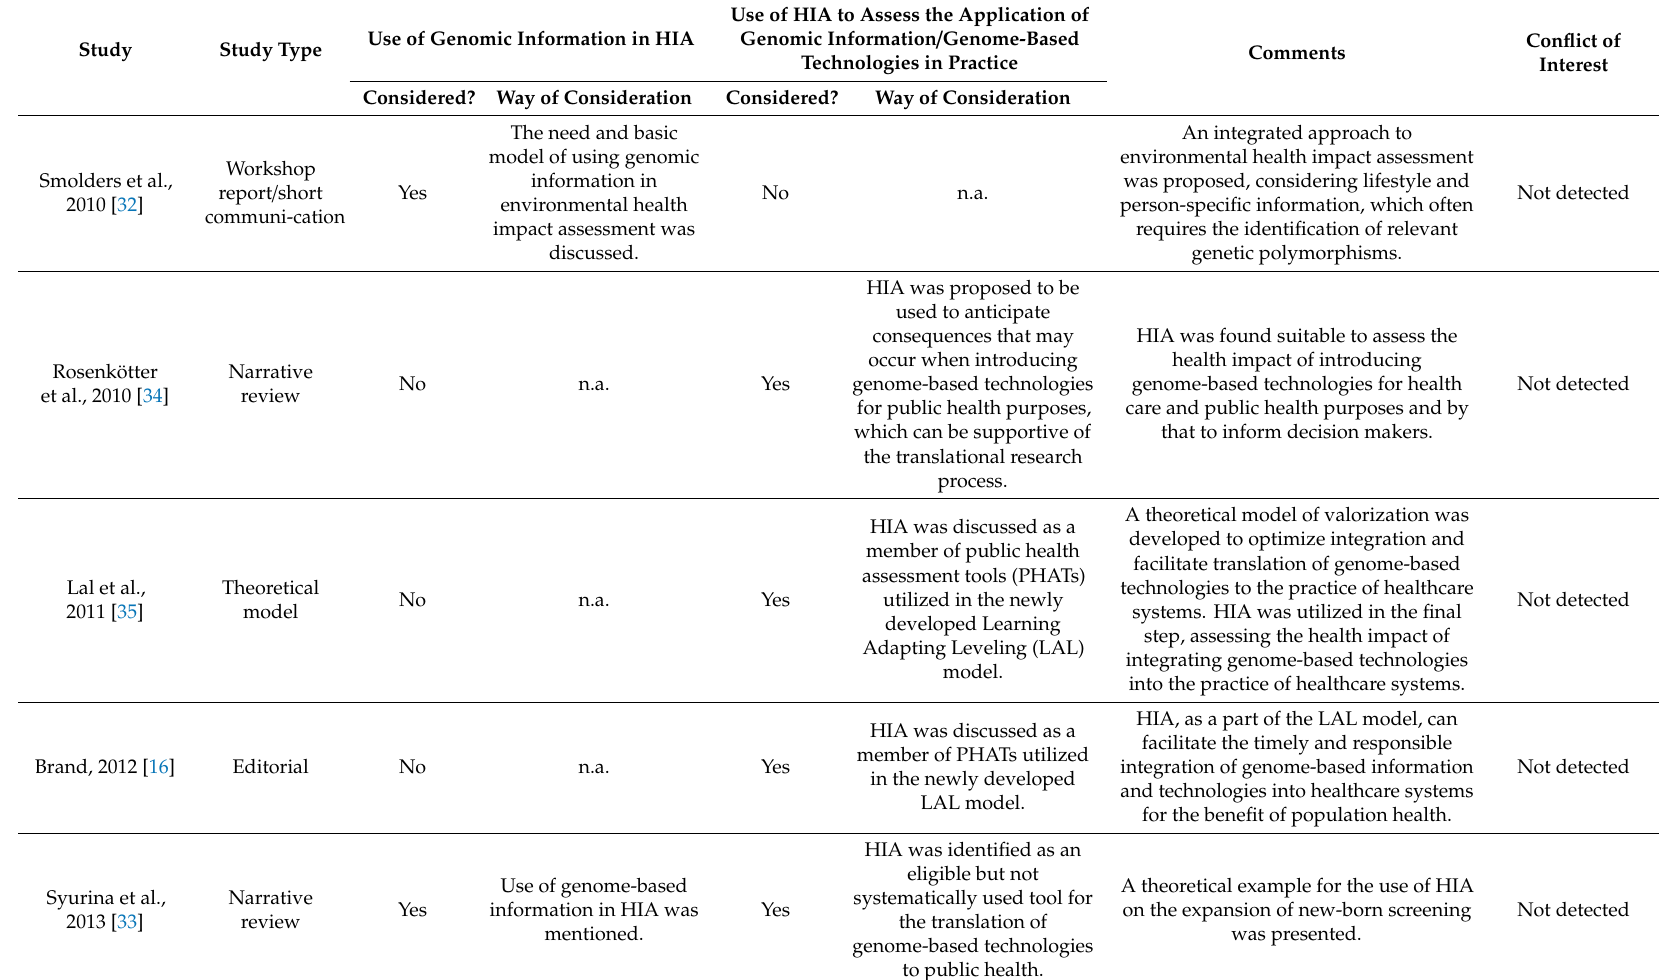
Table 2. Characteristics of the selected